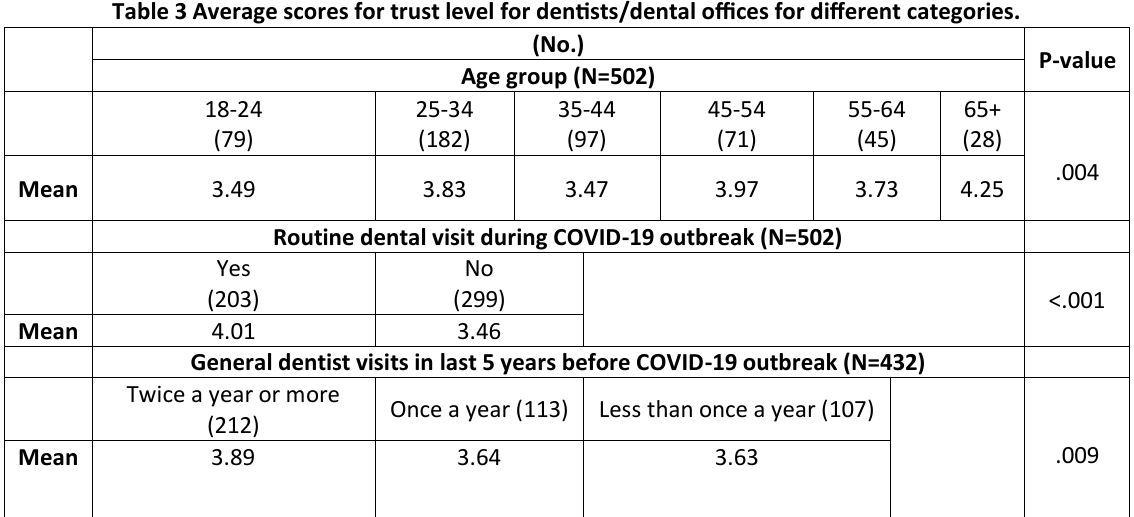
Table 3 Average scores for trust level for dentists/dental offices for different categories.